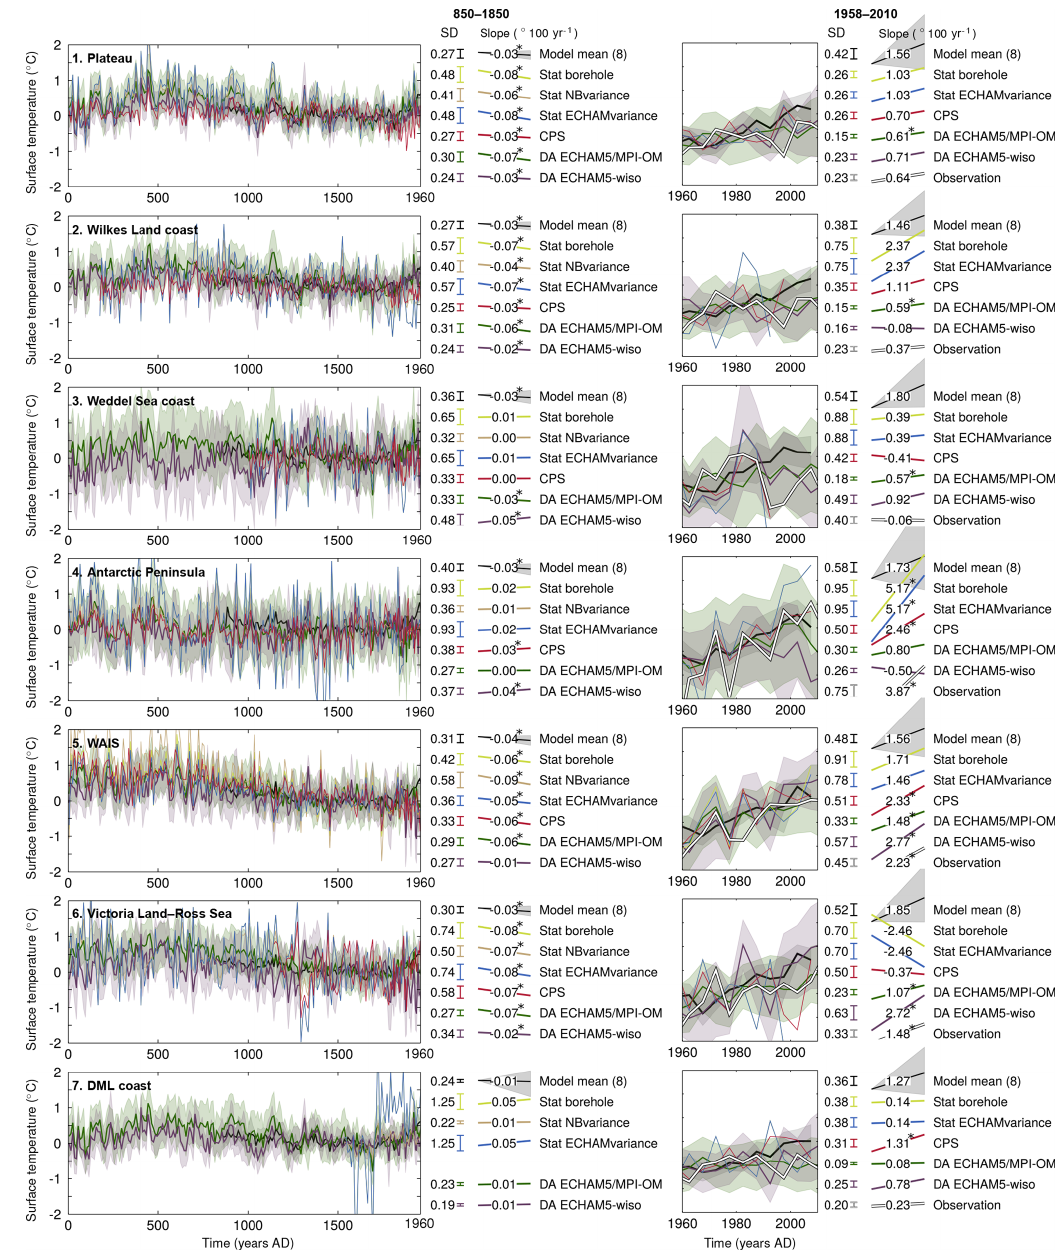
Figure 9. Changes in 10- (left panels) and 5-year averaged (right panels) simulated and reconstructed surface temperature over the 0–2000CE period over the seven Antarctic subregions. The model mean and ± 1 standard deviation of the individual simulations are shown in black and shaded gray, respectively; the statistical reconstructions of Stenni et al. (2017) are shown in yellow, beige and blue. Stat NBvariance uses a temperature scaling based on the temperature observations of Nicolas and Bromwich (2014) over the 1960–2010CE period (see Sect. 2.5), Stat ECHAMvariance uses a temperature scaling based on the simulated δ 18 O–temperature link in a ECHAM5-wiso simulation over the 1979–2013CE period (Goursaud et al., 2018), and Stat borehole also uses a scaling based on the simulated δ 18 O–temperature link in ECHAM5-wiso, but the WAIS region is adjusted to match the temperature trend between 1000 and 1600CE based on borehole temperature measurements from Orsi et al. (2012). The data assimilation reconstructions based on the ECHAM5/MPI-OM and ECHAM5-wiso model ensembles are shown in green and violet, respectively. The uncertainty of the data assimilation-based reconstructions is shown using colored shading ( ± 1 standard deviation of the model particles scaled by their weight around the mean). The reconstructions based on instrumental records observations from Nicolas and Bromwich (2014) are shown using white lines (in the right panels only). The reference period is 1500–1800CE for the left panels, and 1960-1990CE for the right panels. The standard deviation and the slopes of the series (in degree/100 years) are shown for the 850–1850CE (or overlap period) and 1958–2010CE periods; slopes proportional to the numbers are also displayed. When the trends are significantly different from zero according to F tests ( p < 0 . 05), the slope values are followed by an asterisk ( ∗ ). www.clim-past.net/15/661/2019/ Clim. Past, 15, 661–684,